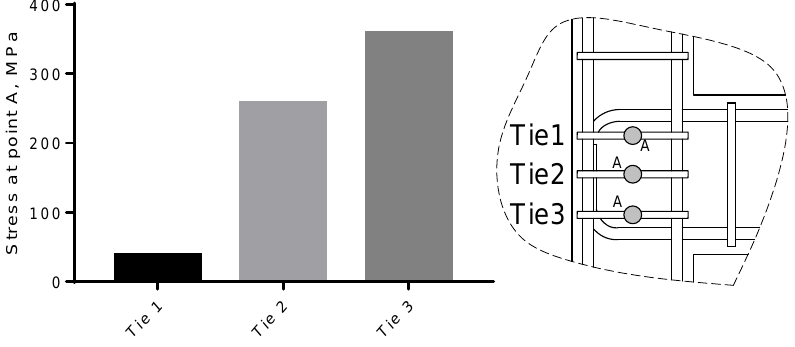
Figure 13. Stresses in transverse stirrups (ties) of joint J1.